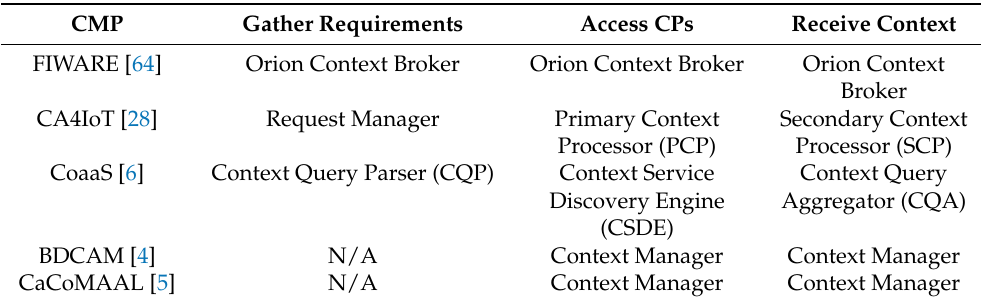
Table 8. Some functionally advanced CMPs and their components that would communicate with a QoC-aware selection and measurement framework. Each column heading, except ‘CMP’, represents the process of the respective component listed.